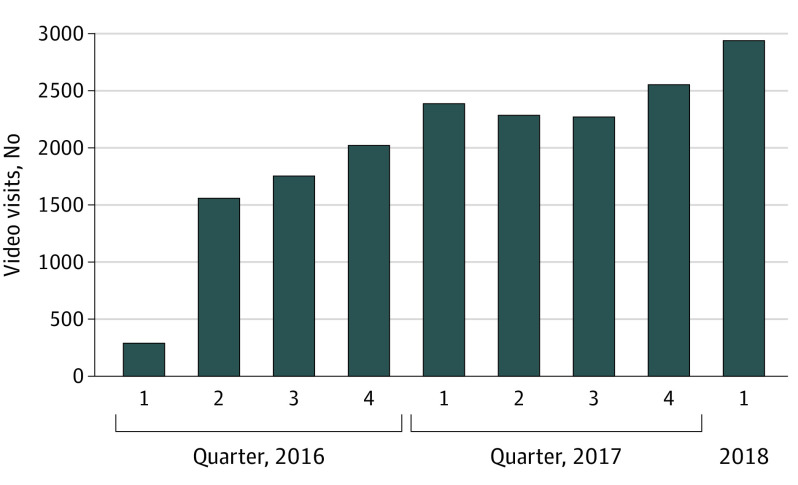
Patient-Scheduled Primary Care Video Visits, by QuarterPatient self-scheduling capability first added to the Kaiser Permanente Northern California patient portal in 2016.